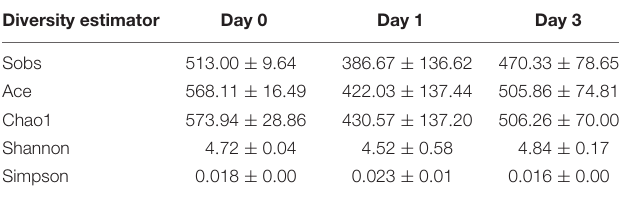
TABLE 2 | Alpha diversity analysis at genus